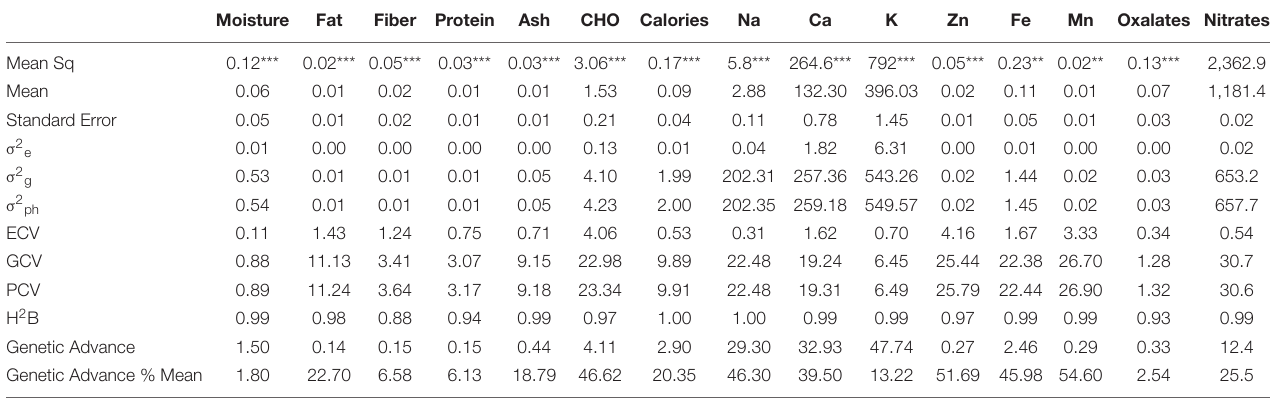
TABLE 2 | ANOVA for nutritional contents of spinach accessions. Moisture Fat Fiber Protein Ash CHO Calories